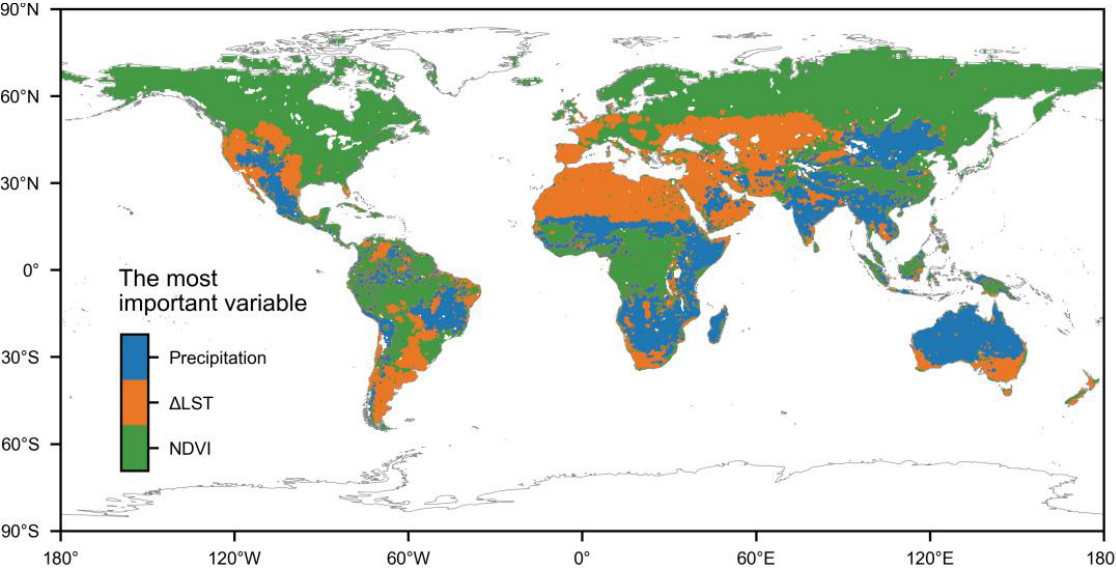
Figure 3. The spatial distribution of the most contributing feature variable in the RF model for SM gap-filling at each pixel.